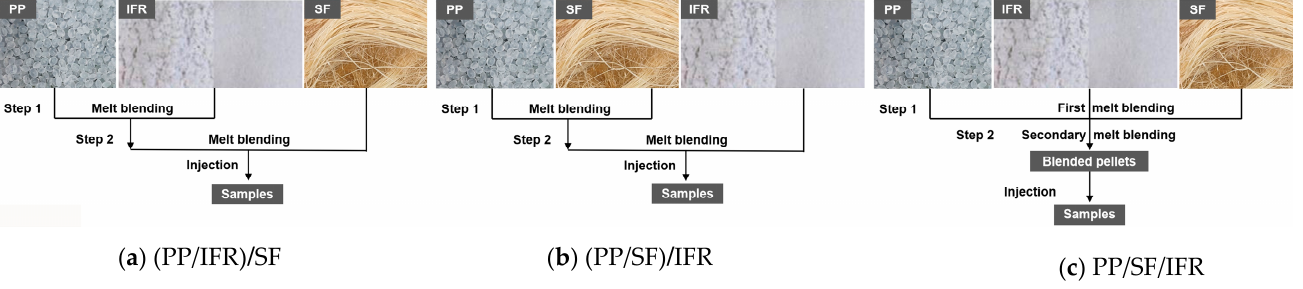
Figure 1. Flow chart of sample preparation of PP/SF flame-retardant composites.